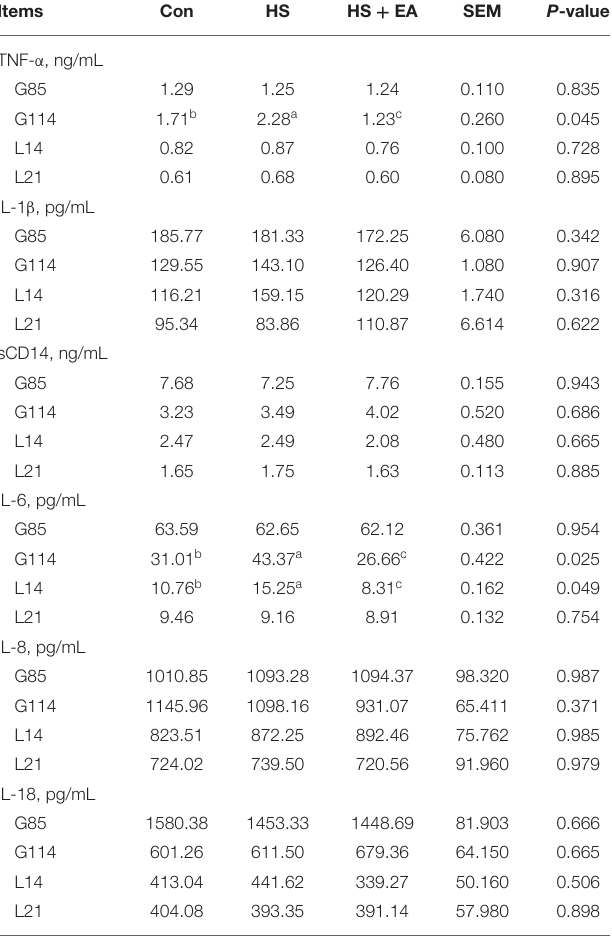
TABLE 5 | Effects of dietary supplementation with EA on the inflammatory cytokine levels in the serum of sows. Items